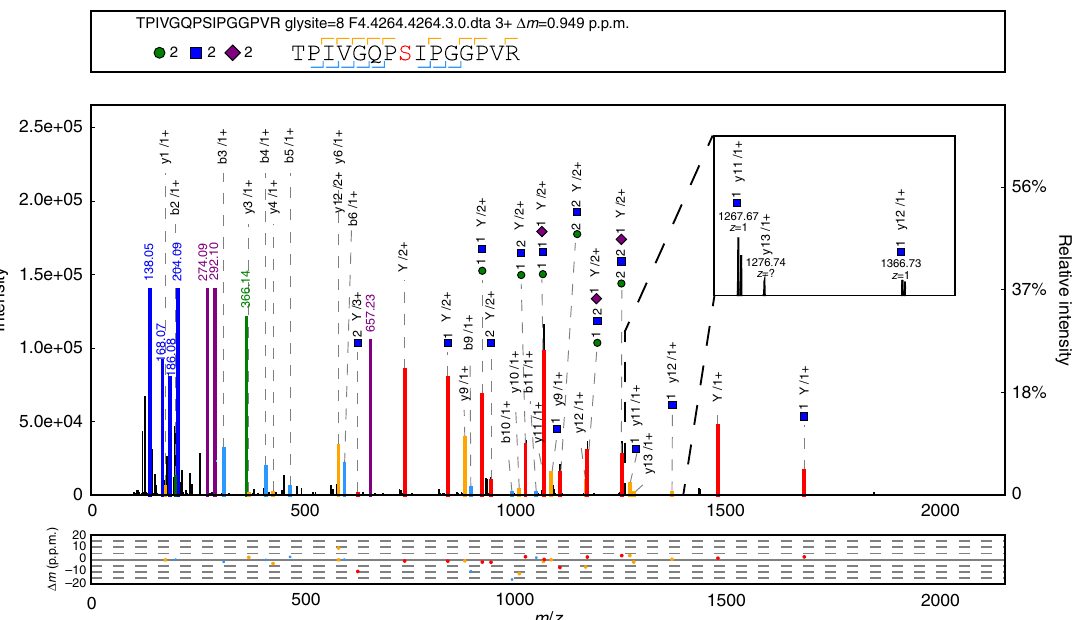
Fig. 9 Example of an O-glycopeptide SCE-HCD-MS/MS spectrum. A high-quality O-glycopeptide spectrum with abundant glycan and peptide fragment ions derived from stepped-energy HCD-MS/MS is shown. The design of the annotation in each spectrum is the same as that in Fig. 1. This O-glycopeptide has two potential glycosylation sites: T1 and S8. The three diagnostic ions with a HexNAc attached show that S8 is the glycosylation site: y9 + HexNAc ( m/ z = 1082.59, 1 + ), y11 + HexNAc ( m/z = 1267.67, 1 + ), and y12 + HexNAc ( m/z = 1366.73, 1+). A zoom-in fi gure of the latter two fragments is shown in